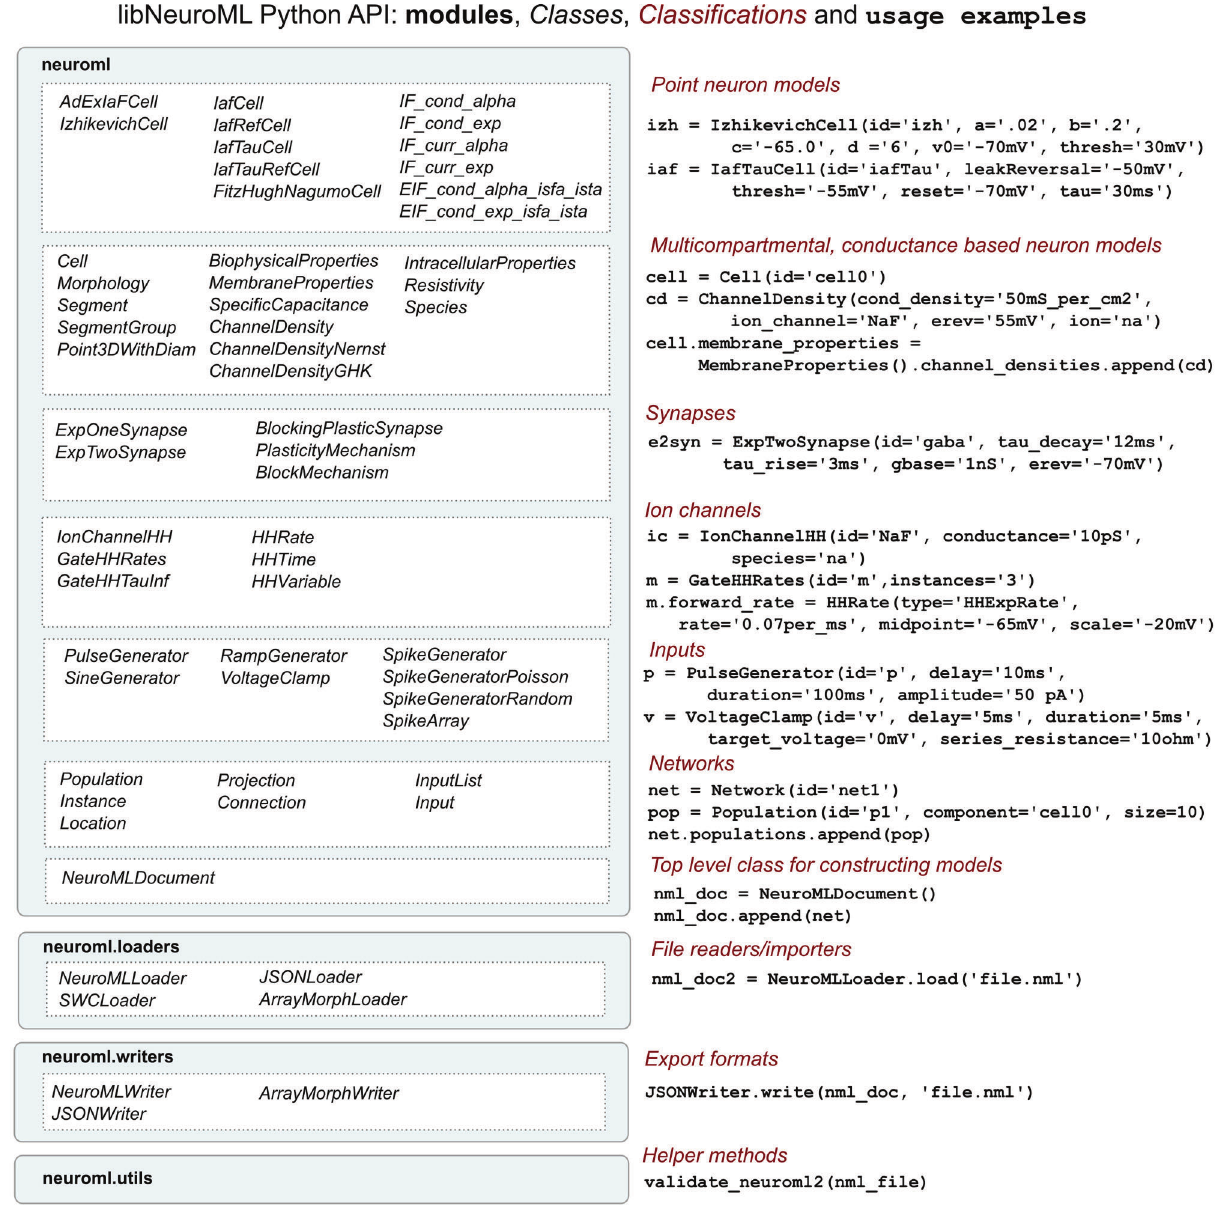
number of broad classifications (right) based on the types of models they represent. Examples of Python code using the classes is also shown on the right. Extra modules have been created to facilitate loading or writing NeuroML (in XML or other serialization formats) and for validating NeuroML